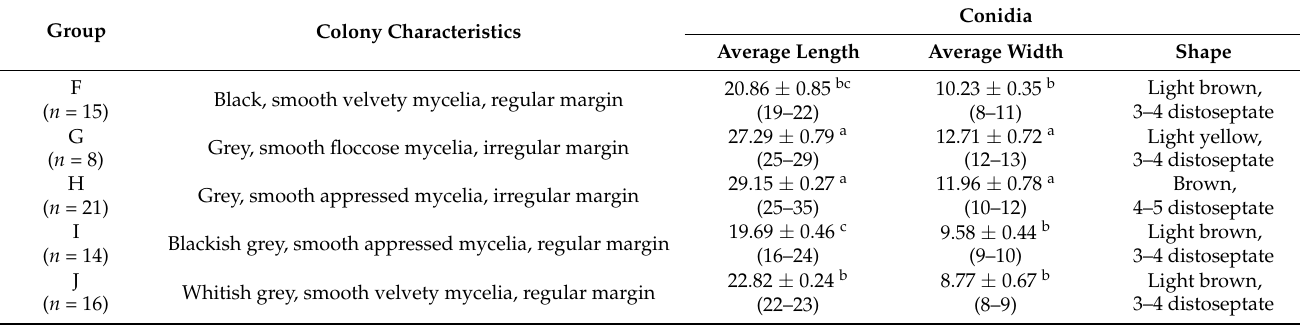
Table 4. Morphological characteristics of Curvularia